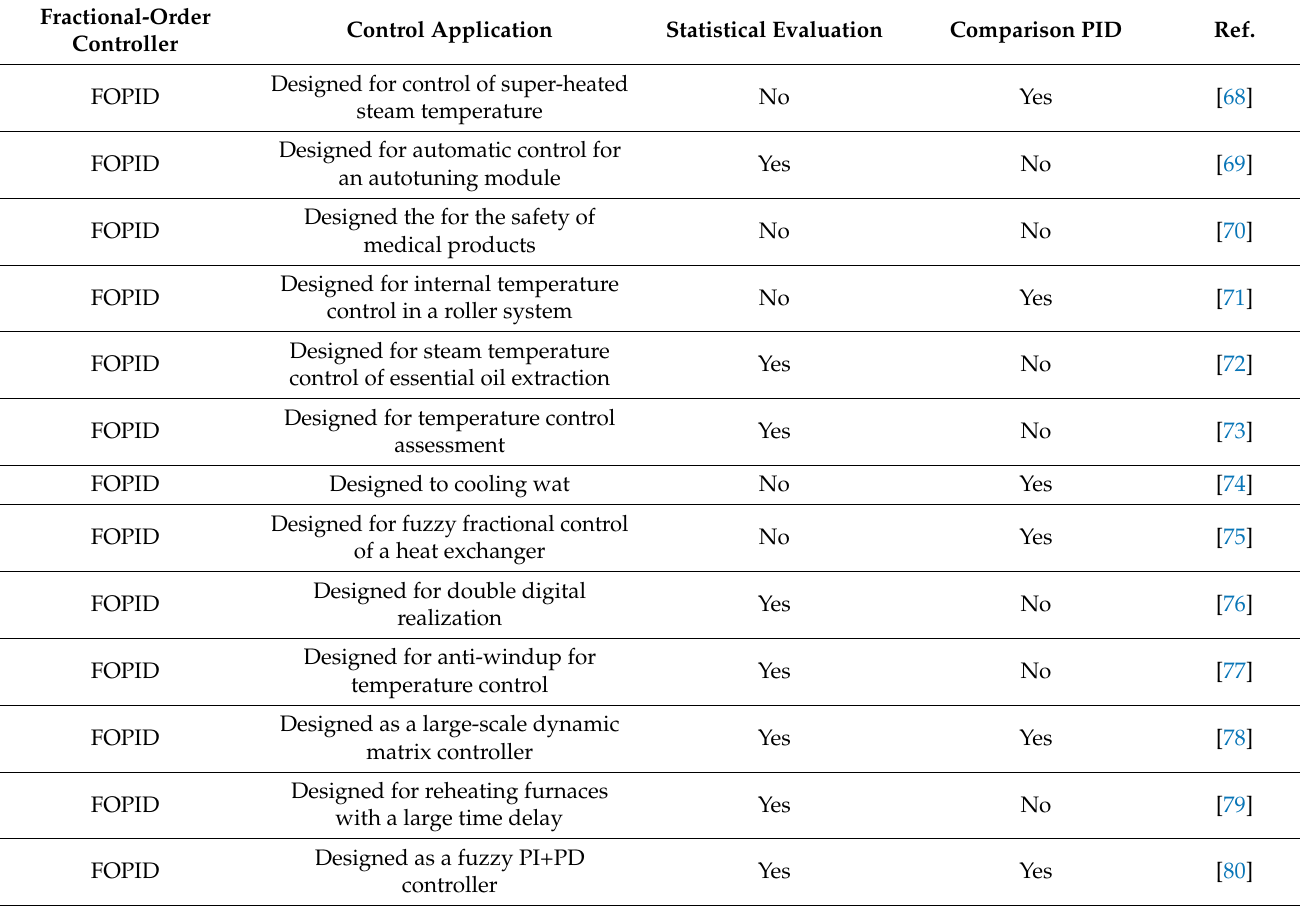
Table 2. Usage comparison of a fractional-order PID controller for temperature